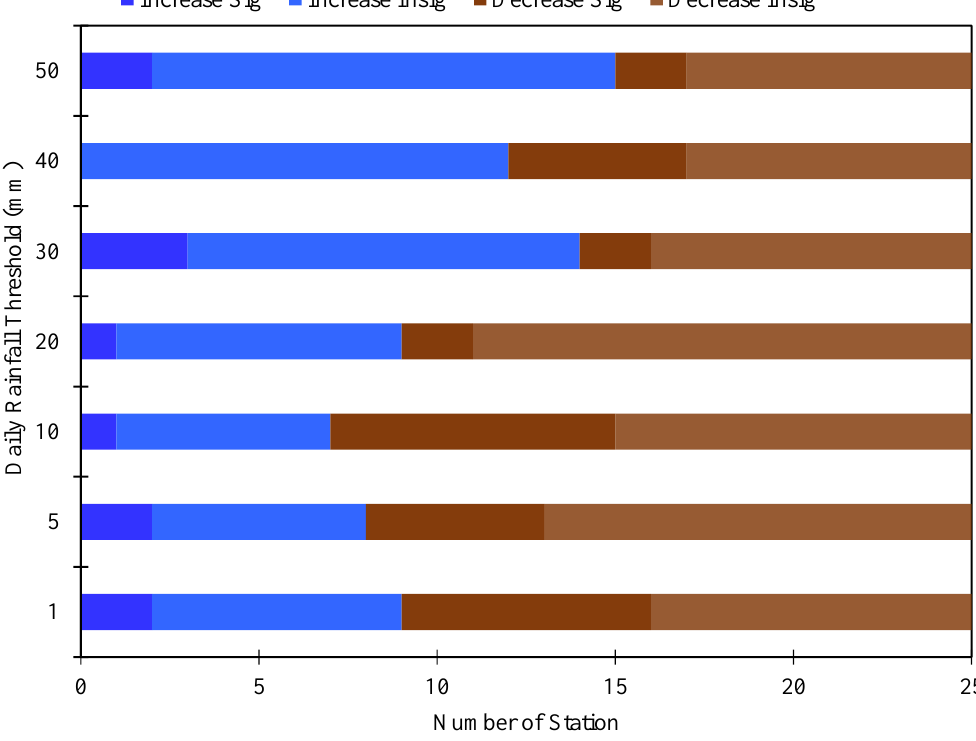
Figure 12. The number of stations with extreme rainfall trends increasing (blue) and decreasing (brown) at different thresholds for the period 1978–2019.